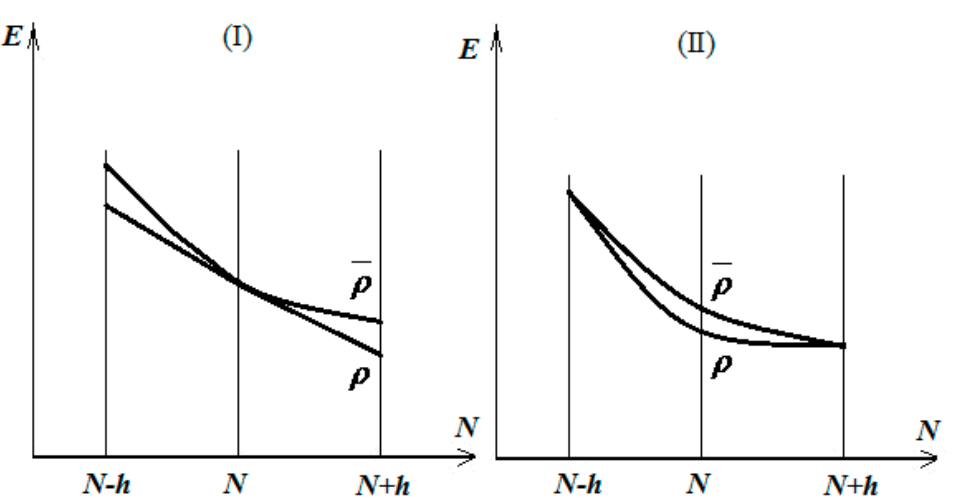
Figure 1. The two cases of the total energy minimization by distinctly acting on the parabolic energetic shape connecting the electronic states | N − h (cid:105) , | N (cid:105) , and | N + h (cid:105) ; see the text for details. Firstly, in both analyzed cases in Figure 1, the electronegativity approaches its mini- mum on the right ground density ρ , around the electronic state | N